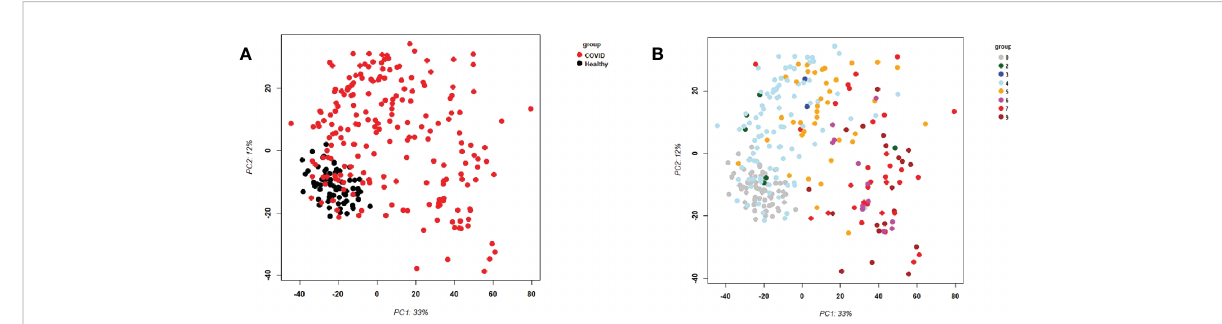
FIGURE 1 Principal Component Analysis (PCA) of all samples. PCA plot of PC1 and PC2. (A) Representing infected participants (COVID) and healthy controls (Healthy) by different colors. (B) Representing infected (COVID) participants by WHO severity (levels 2 to 9) and healthy controls (level 0) by different intensities of red. Abbreviations: 0, 2, 3, 4, 5, 6, 7, and 9 stand for WHO severity level 0, 2, 3, 4, 5, 6, 7, and 9, respectively. Note that our cohort did not have participants at levels 1 and